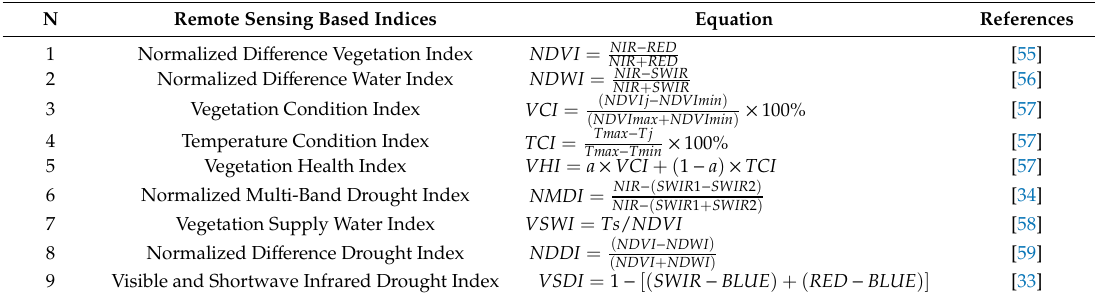
Table 2. Equations of tested nine remote sensing